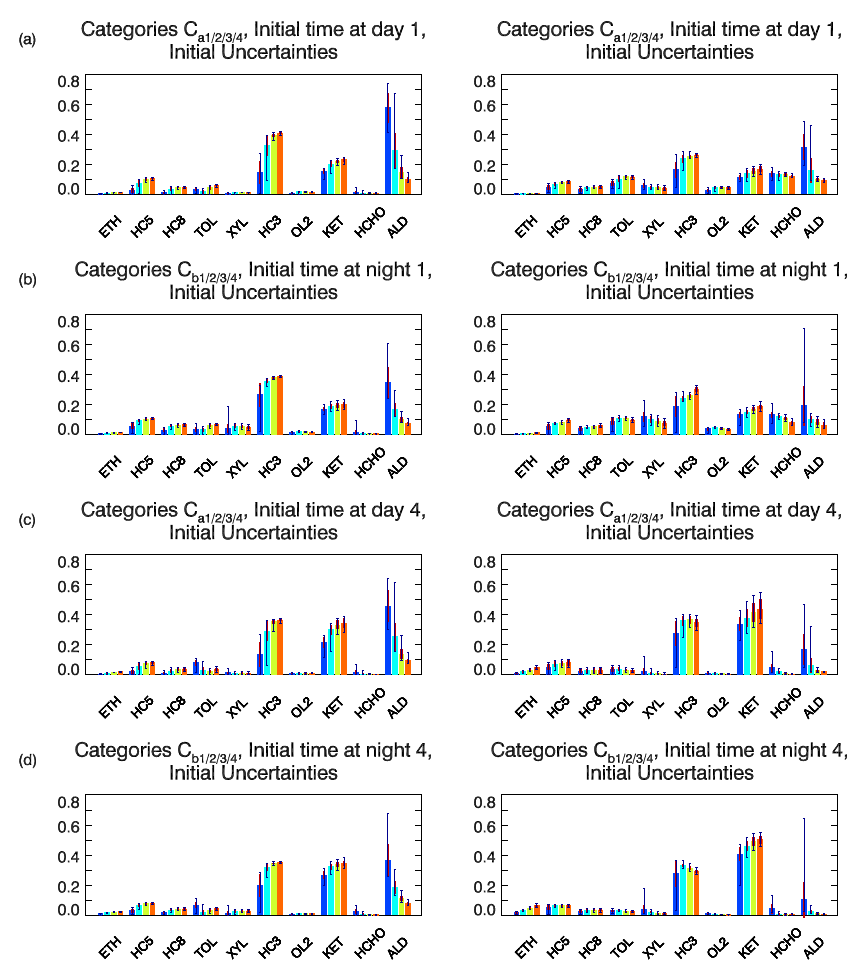
Fig. 6. Statistics of optimal projected relative singular vectors with respect to initial uncertainties for scenario PLUME (left panel column) and scenario URBAN (right panel column) for (a) day 1, (b) night 1, c) day 4, and (d) night 4. Displayed are results for categories C a 1 / 2 / 3 / 4 and C b for the VOCs with the most influence. All panels depict mean impact ( C a 1 /b 1 : blue bars, C a 2 /b 2 : turquoise bars, C a 3 /b 3 : green bars, C a 4 /b 4 : orange bars), minimum/maximum value (dark blue lines) and standard deviation (red bars).